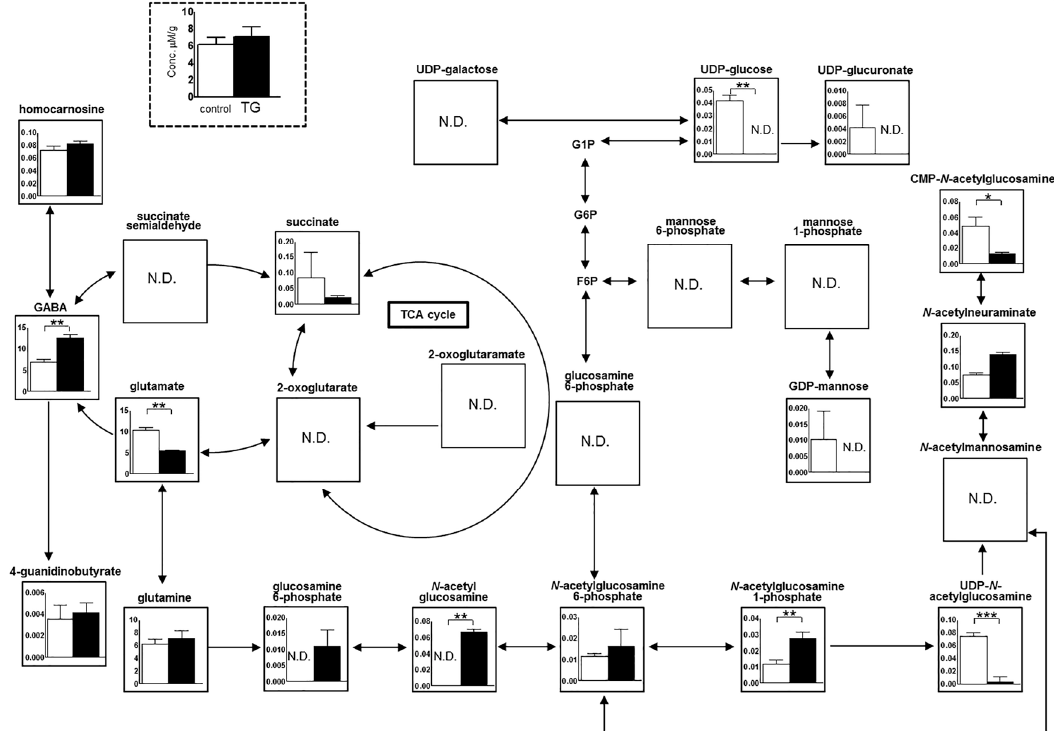
Figure 6. Metabolic analyses of the hippocampus. Metabolomic profiles in the hippocampus were analyzed by capillary electrophoresis-time of flight-mass spectrometry. Several metabolites, including amino acids, were found at higher levels in the hippocampus of Bdnf -HA transgenic (TG) mice compared with C57BL/6 control mice. Each bar represents mean ± SEM of C57BL/6 control mice ( n = 3) or TG mice ( n = 3); N.D. indicated not detected. * p < 0.05, ** p < 0.01, *** p < 0.001, Student’s t -test. One way arrow; direct conversion between metabolites, bidirectional arrow; inter-changeable metabolites.